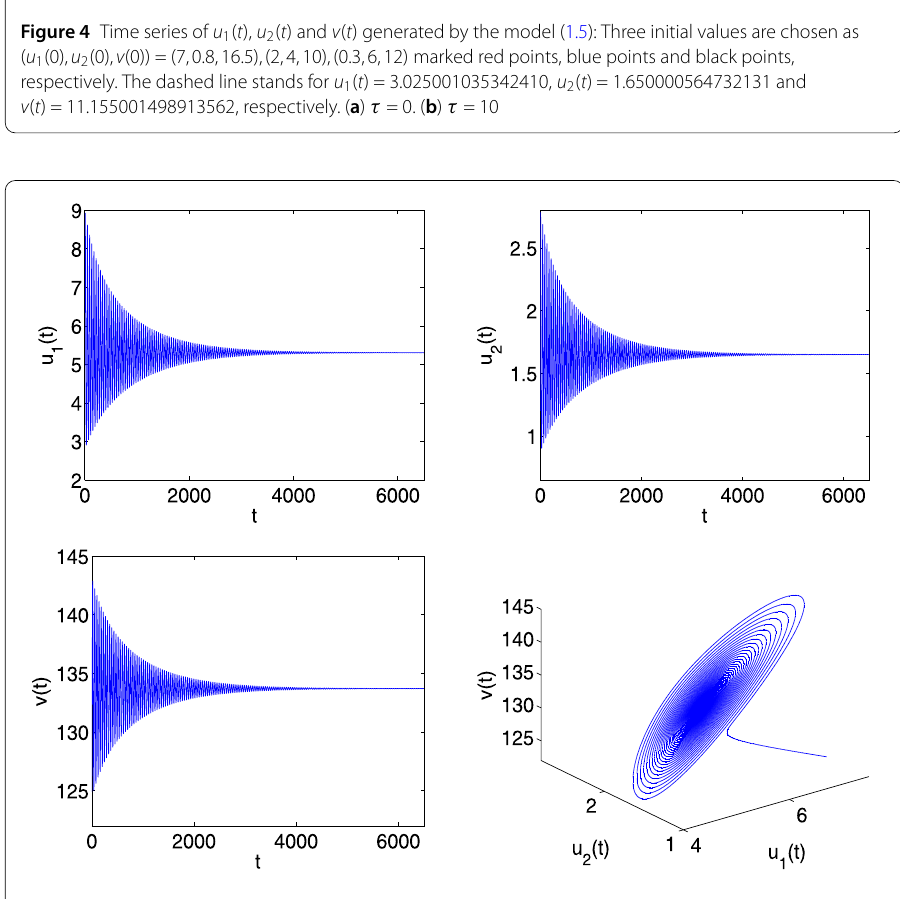
Figure 5 Time series of u 1 ( t ), u 2 ( t ), v ( t ) and phase portrait of the model (1.5) with τ = 0.06 < τ 0 = 0.1509514710143546. An orbit from the initial condition ( u 1 (0), u 2 (0), v (0)) = (7,1.2,125) located in a sufficiently small neighborhood of the equilibrium E 2 (5.303571428572600,1.650000000000400, 133.712142857161200) converges to the equilibrium E 2 . The simulation results indicate that the equilibrium